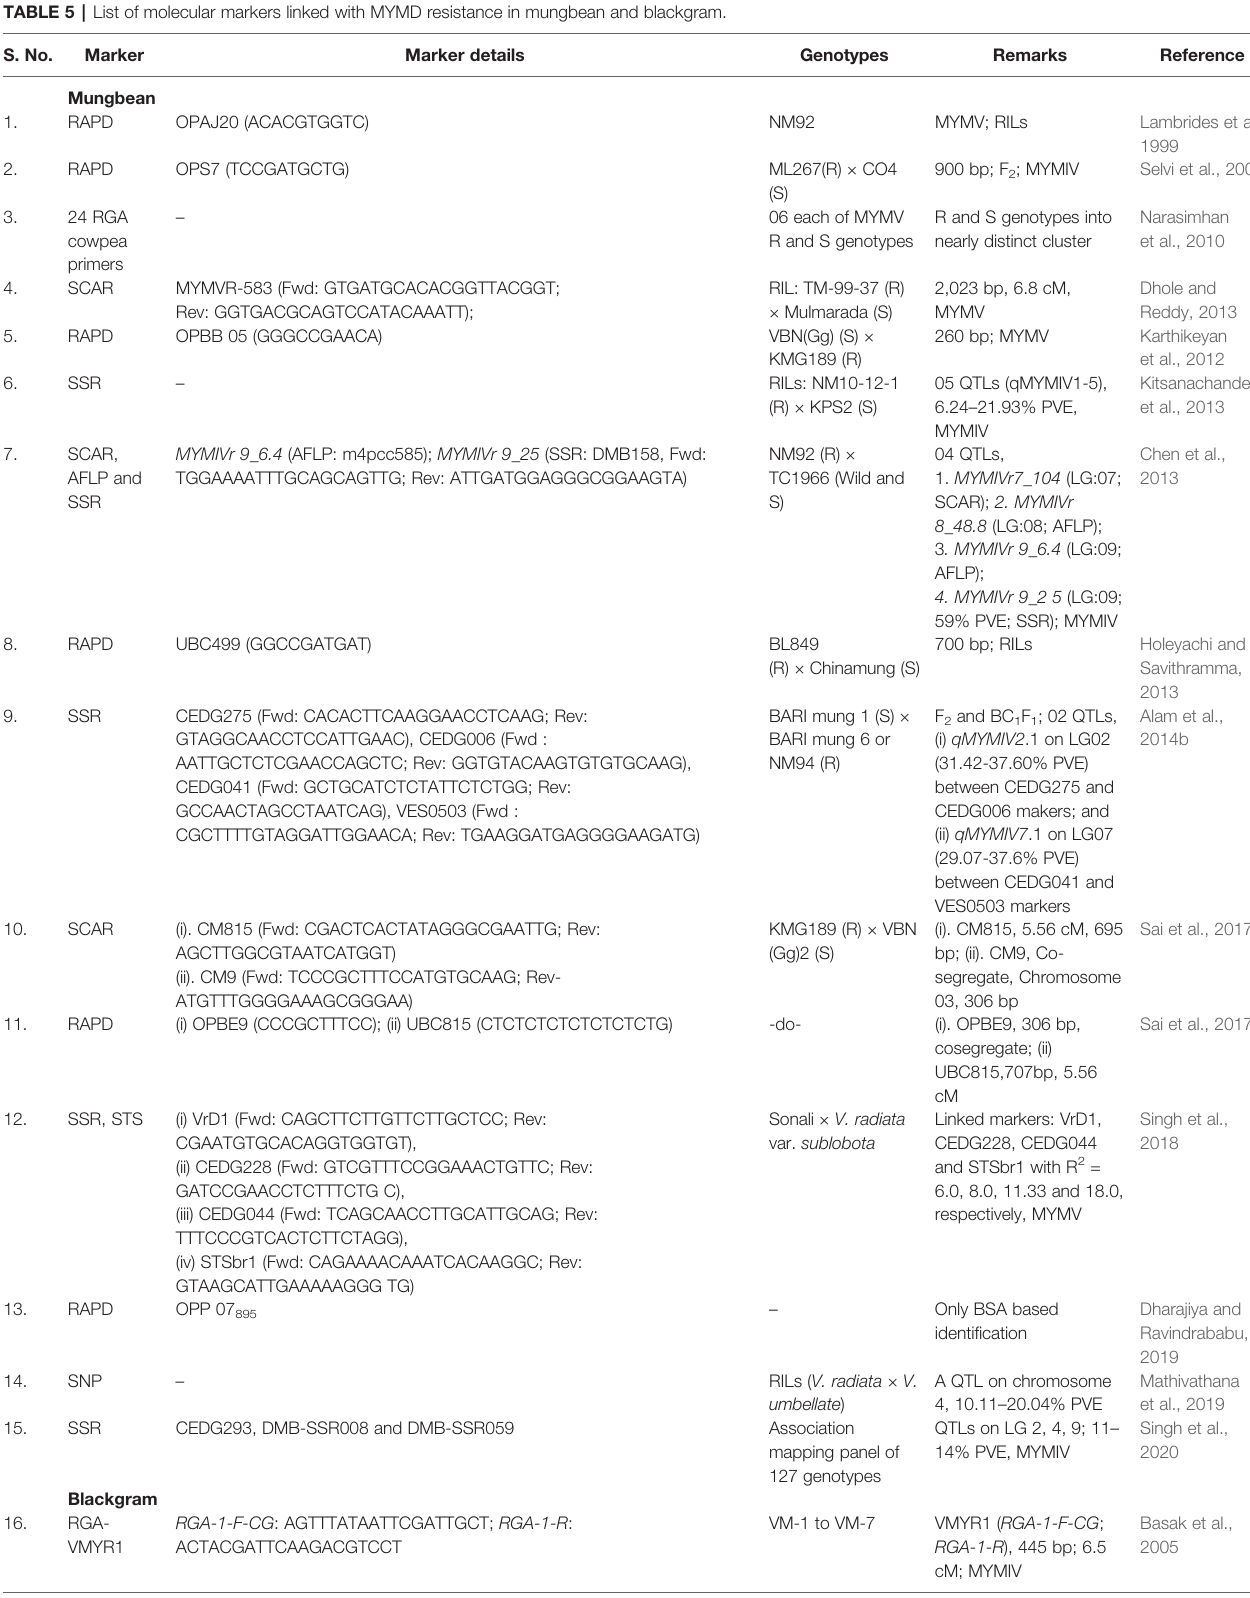
TABLE 5 | List of molecular markers linked with MYMD resistance in mungbean and blackgram. S.